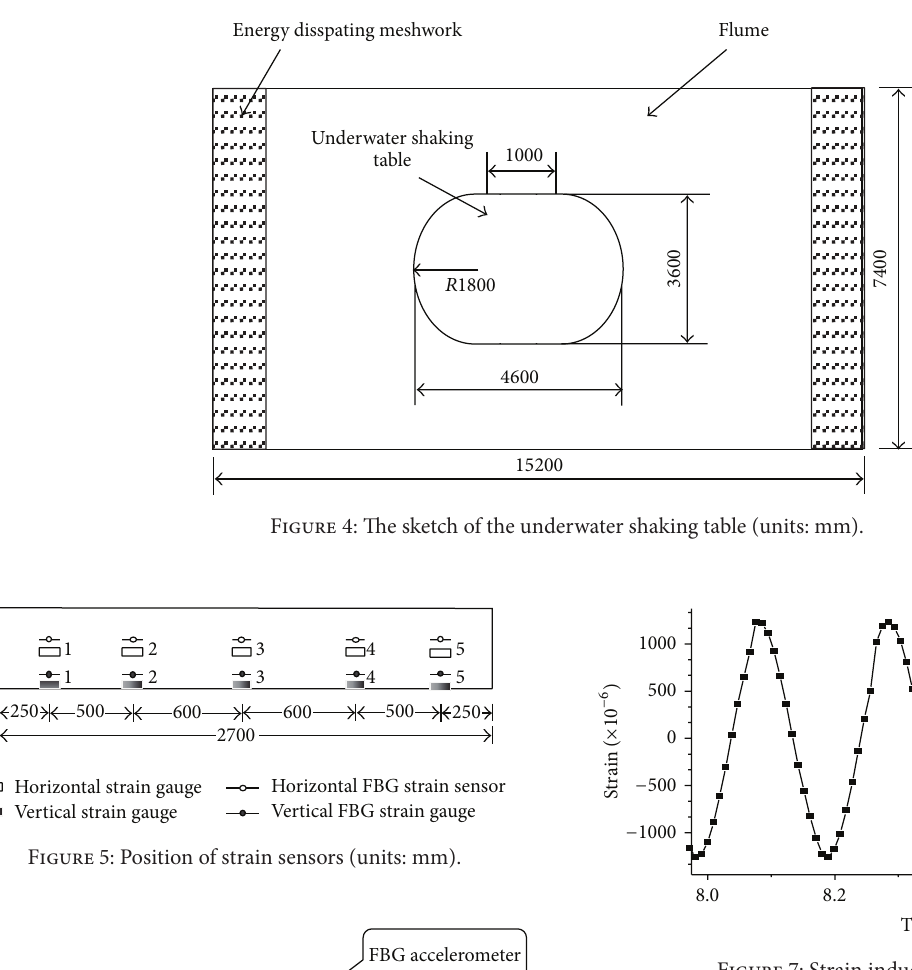
Figure 7: Strain induced by sine